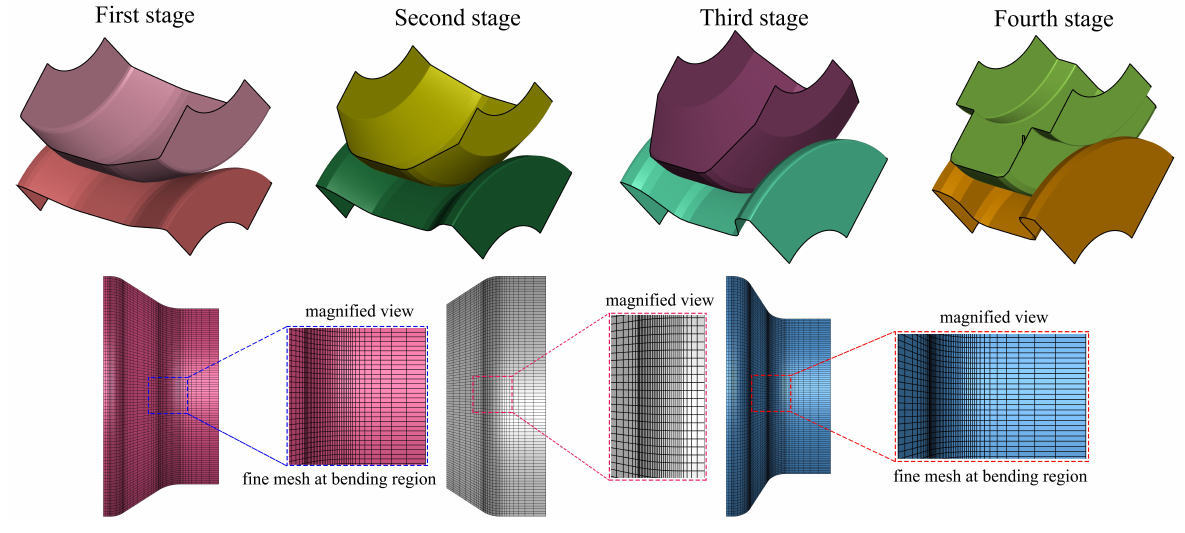
Figure 5. Roll forming process reduced mesh models for the constant arc length method.